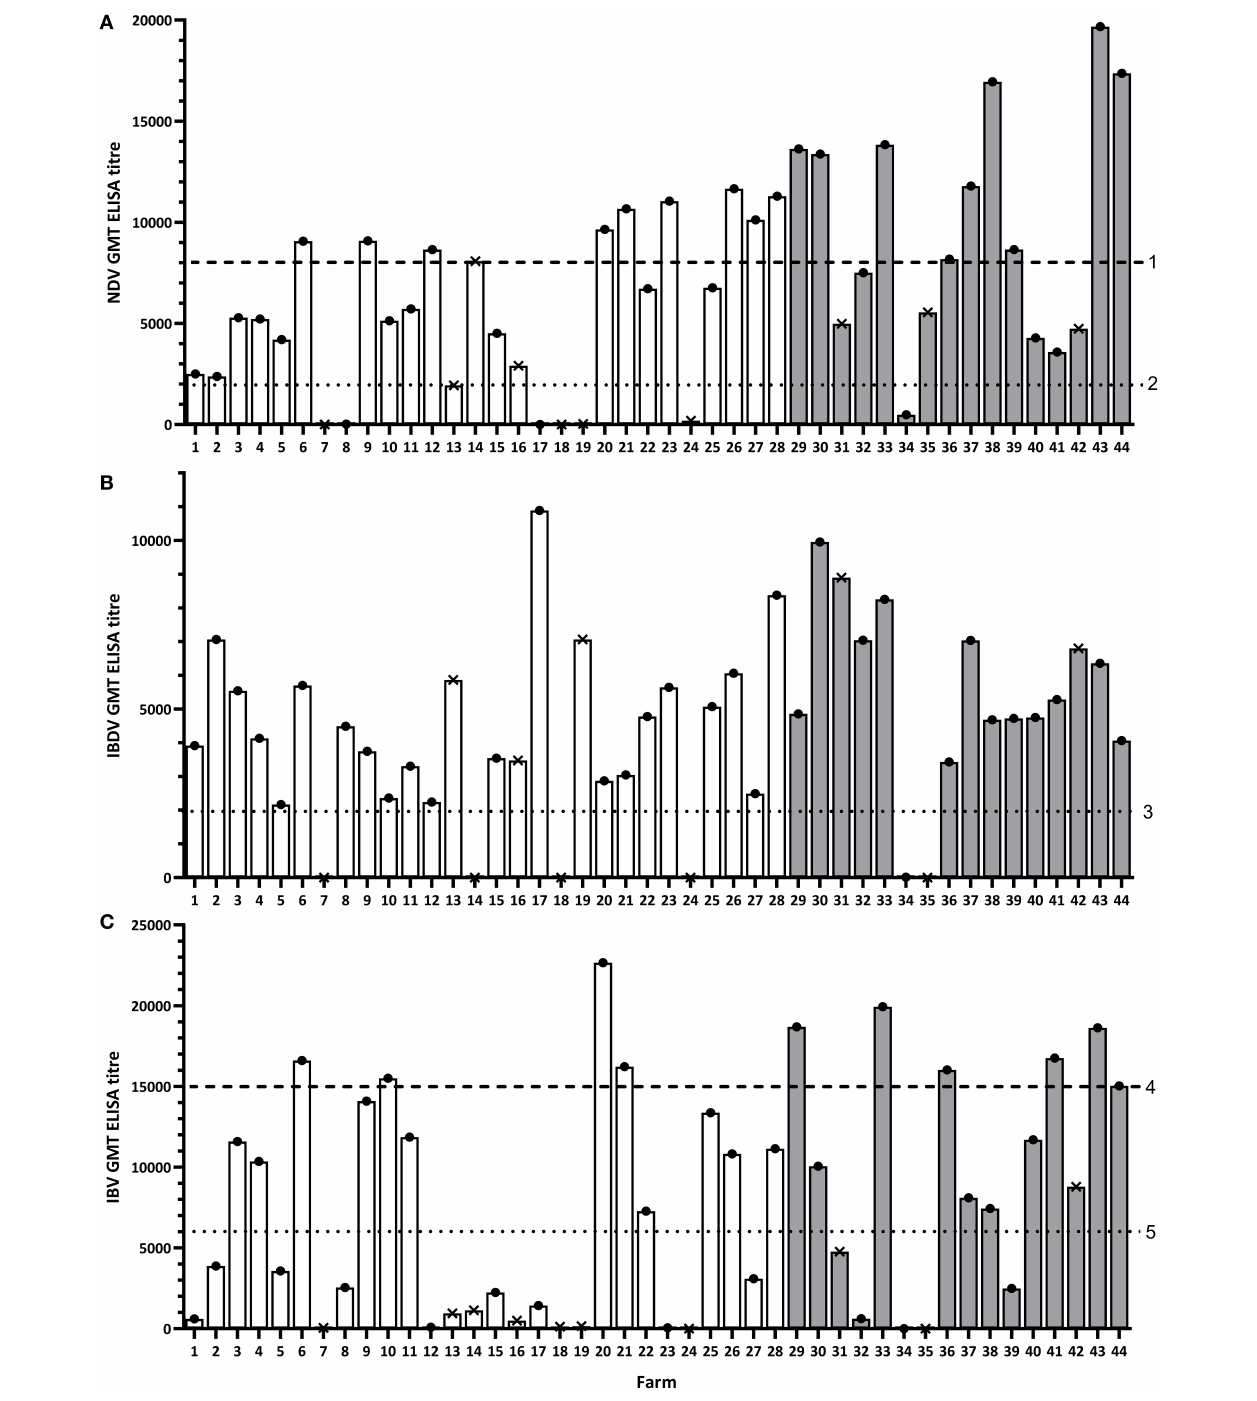
FIGURE 2 | Geometric mean antibody titer (GMT) results for each study flock for NDV (A) , IBDV (B) , and IBV (C) . Dashed lines represent the recommended minimum titer that is considered protective after administration of the specified vaccine in the study region: 1, ND killed virus vaccine; 2, ND live virus vaccine; 3, IBD live/killed virus vaccine; 4, IB killed virus vaccine; 5, IB live virus vaccine. White bars represent flocks in Kano, gray bars represent flocks in Oyo. Dots and crosses at the top of bars represent layer and broiler flocks, respectively.